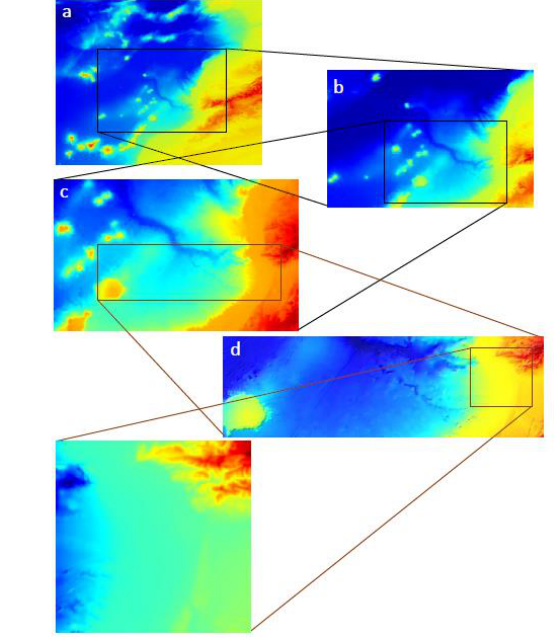
Figure2 . Grids creation; a) R=0,004 b) R=0,002 c) R=0,001 d) R=0,0005 e) R=0,00025